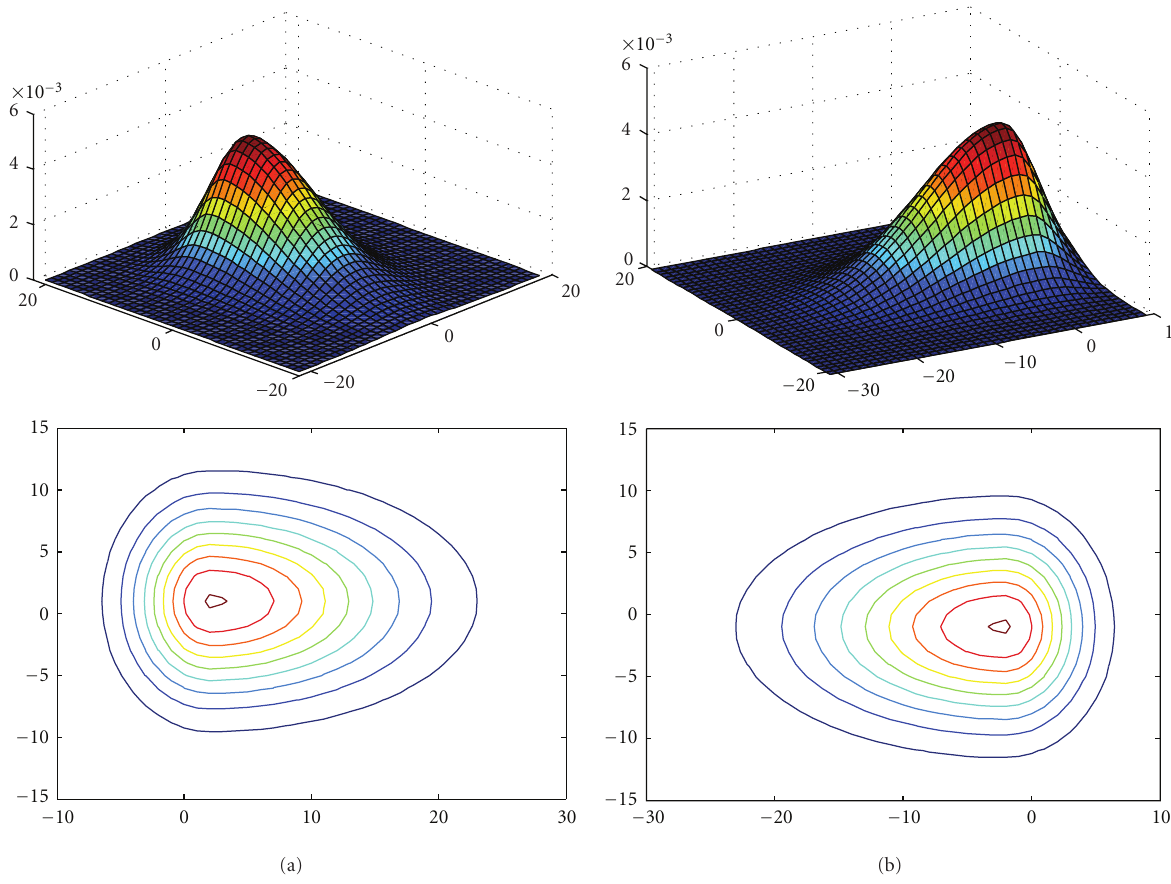
= 10, σ = 4, (b) probability distribution of f ( x x 2 1